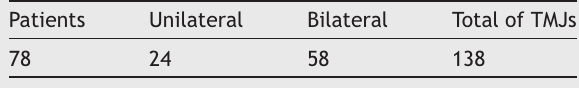
Relationship between patients and affected TMJs.